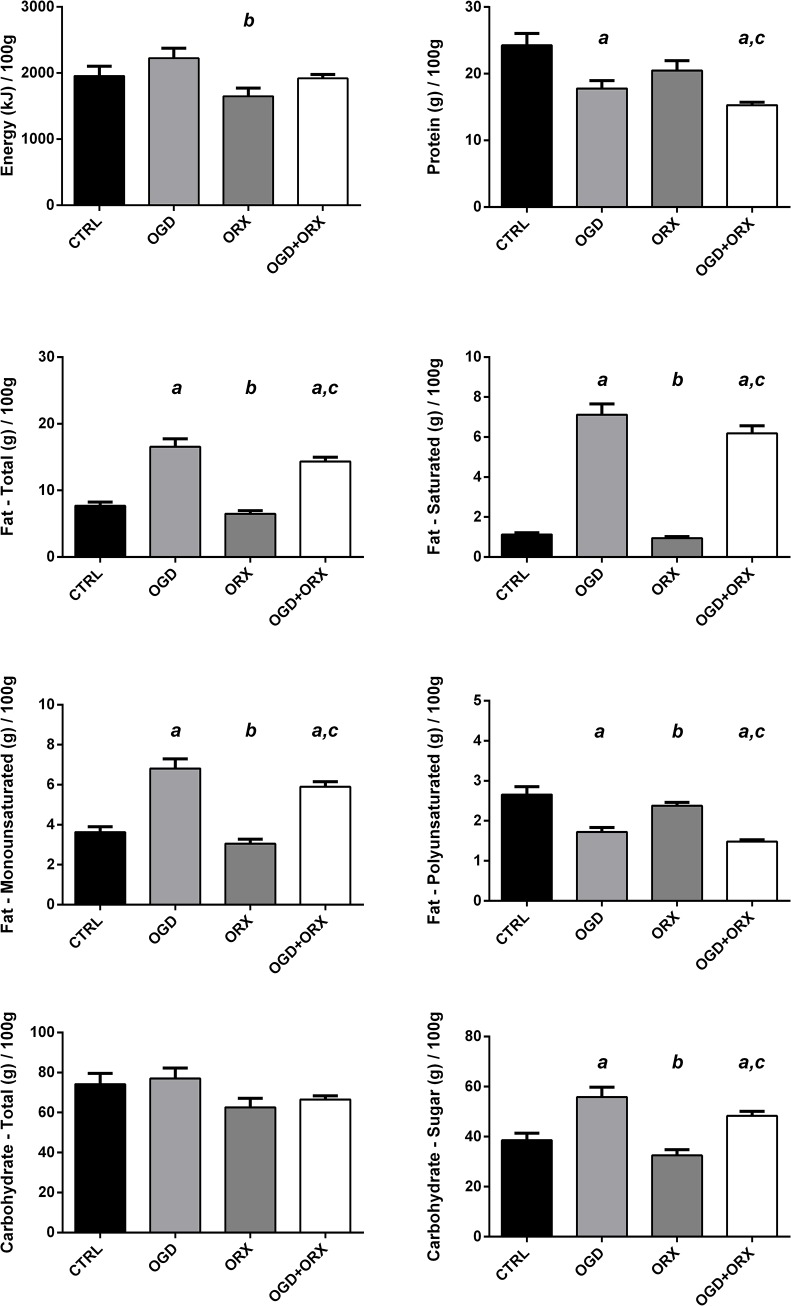
Daily energy and macronutrient intake.CTRL–control, OGD–obesogenic diet-fed, ORX–orchiectomised. Letters denote significant differences between respective groups, p<0.05 (a vs. CTRL, b vs. OGD, c vs. ORX).